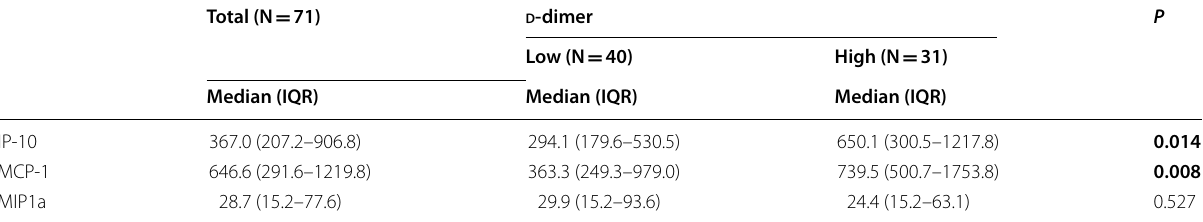
Bold indicates the statistically significant values ( P < 0.05)